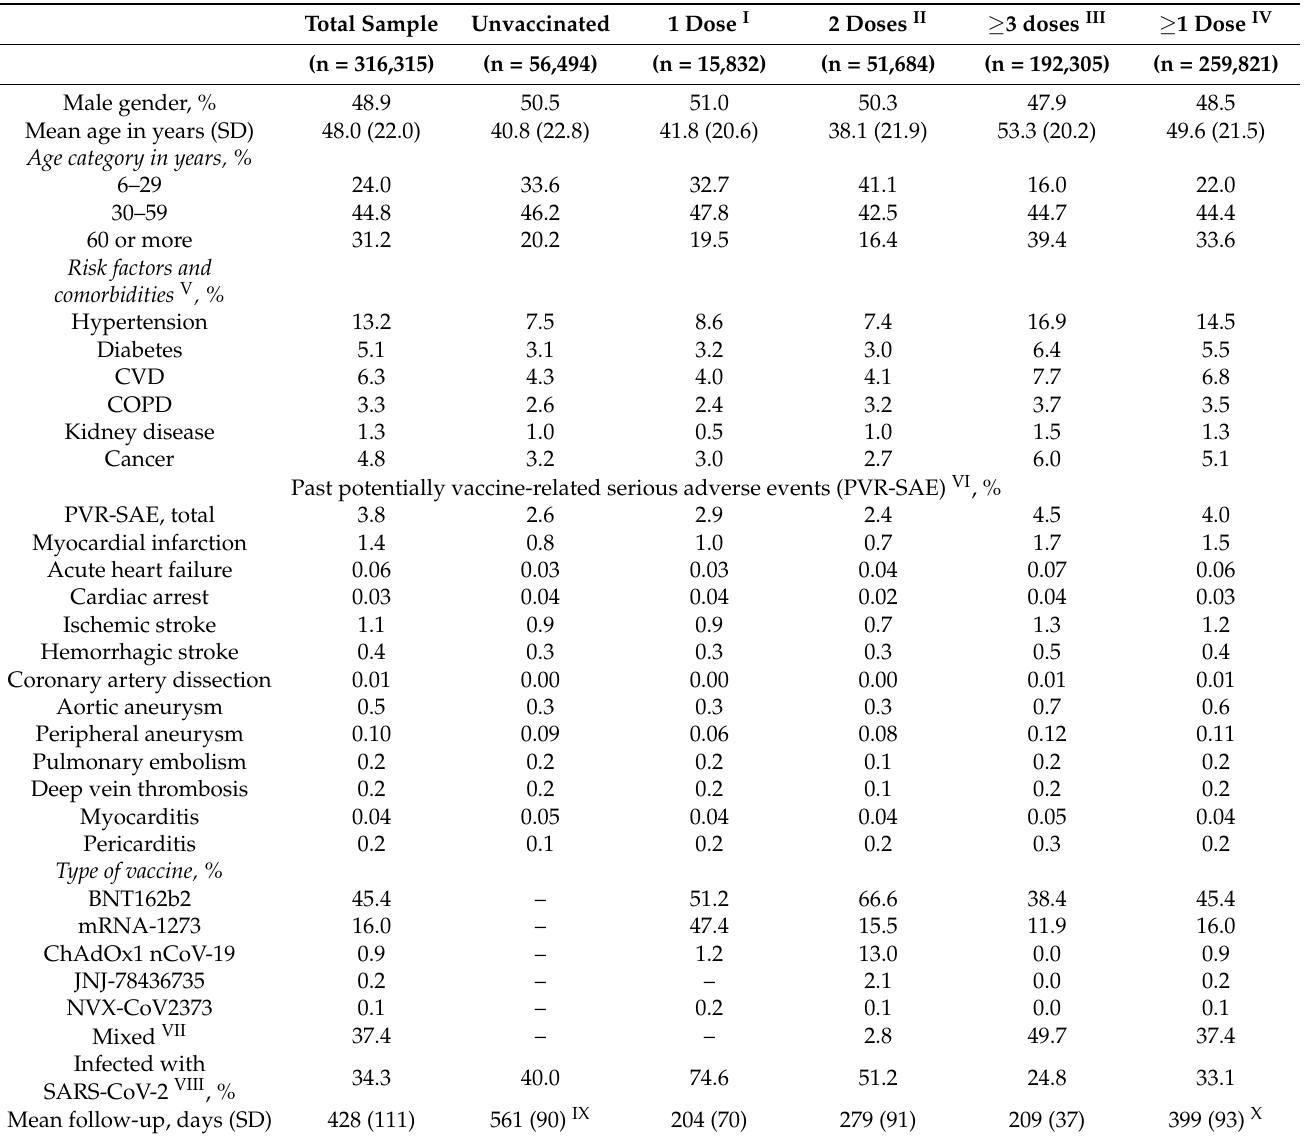
Table 1. Main characteristics of the sample, overall and by COVID-19 vaccine status. Total